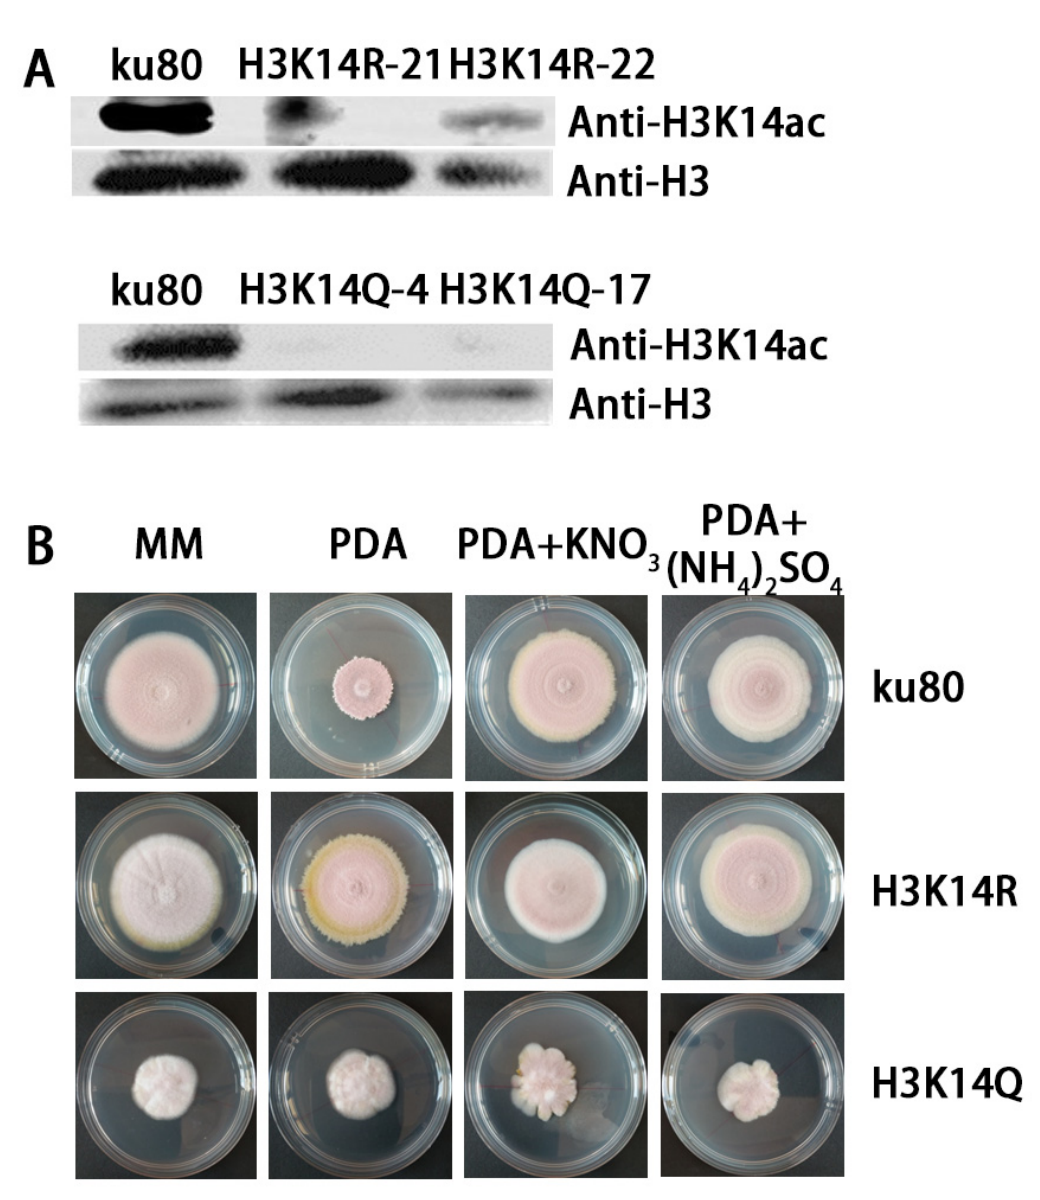
Figure 2. Modification of histone H3K14 affects the growth and conidium of P. lavendulum . ( A ) Western blot Q and H3K14Q strains. ( B ) Growth comparison of Histone H3K14R and the H3K14Q mutant, and the ku80 strain on four media: MM, PDA, PDA+KNO 3 and PDA+(NH 4 ) 2 SO 4 .